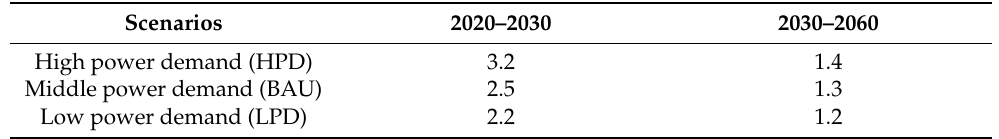
Table 2. Three scenarios for electricity demand growth (%).